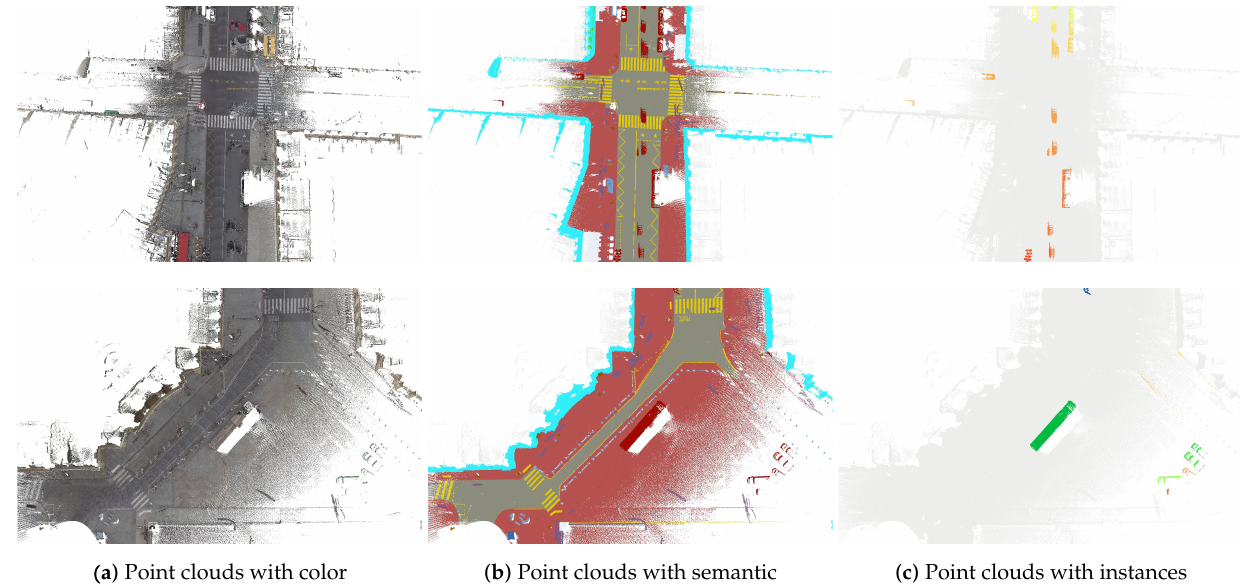
Figure A2. Paris Validation set . From top to bottom: S 4 , S 5 (real data). Figure A2. Paris validation set. From top to bottom : S 4 , S 5 (real data).